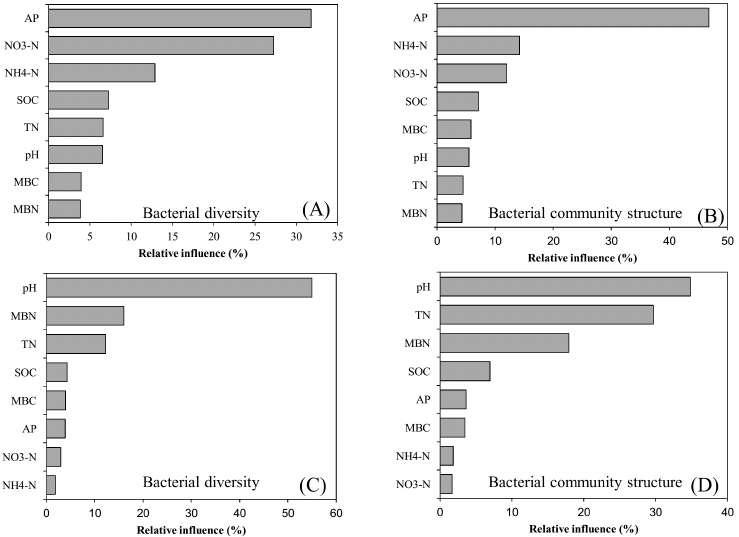
Figure 6. Relative influence of the driving factors for bacterial diversity and community structure as